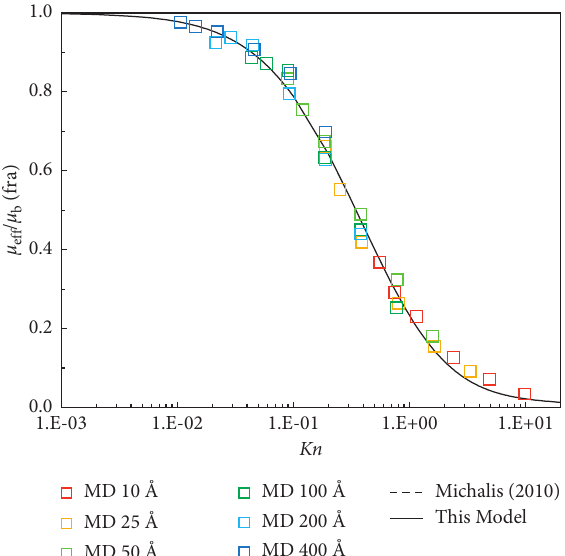
Figure 7: The relative viscosity ( µ eff / µ b ) with Kn (the symbols represent the result of MD simulation, the black lines is the result of this model, the dash line is the results of dilute methane gas by the methods in the literatures). Figure 8: The multiple of gas flow capacity increased in the slit pore with pressure for different width pores at 343.15 K (the symbols represent the result of MD simulation, and the lines are the result of equation